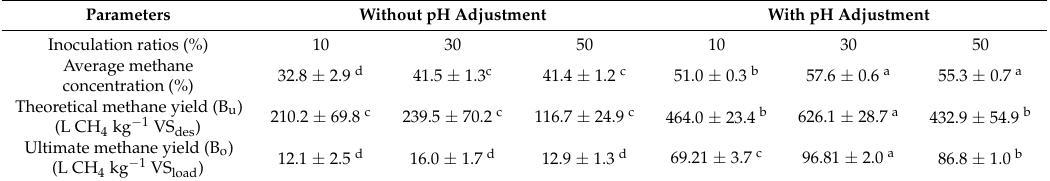
Table 4. Effect of different groups of SSAD on average methane concentration and